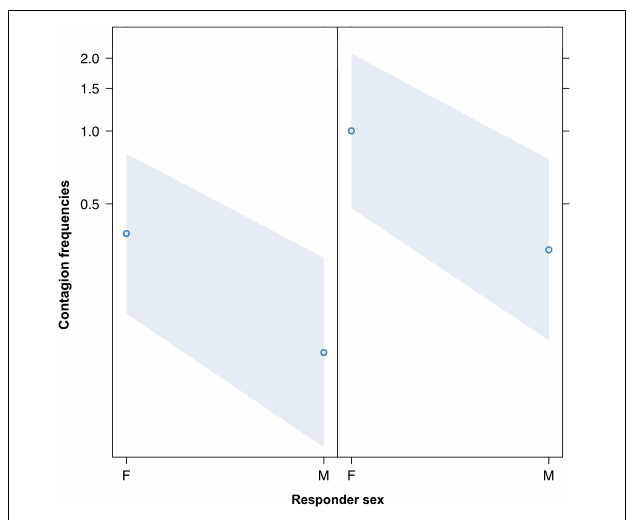
FIGURE 3 | Line plot of the effect of the sex of the responder ( X -axis) on acoustic yawn contagion mean occurrence ( Y -axis). Effect of the responder sex on acoustic yawn contagion when the trigger is a female ( right ) or a male ( left ). Females respond significantly more than males regardless of the sex of the trigger (result of the GLMM, p = 0.021). Points represent the effect that the response variable has on the independent variable “sex of the responder,” based on the value predicted by the model. Colored bands show the 95% confidence